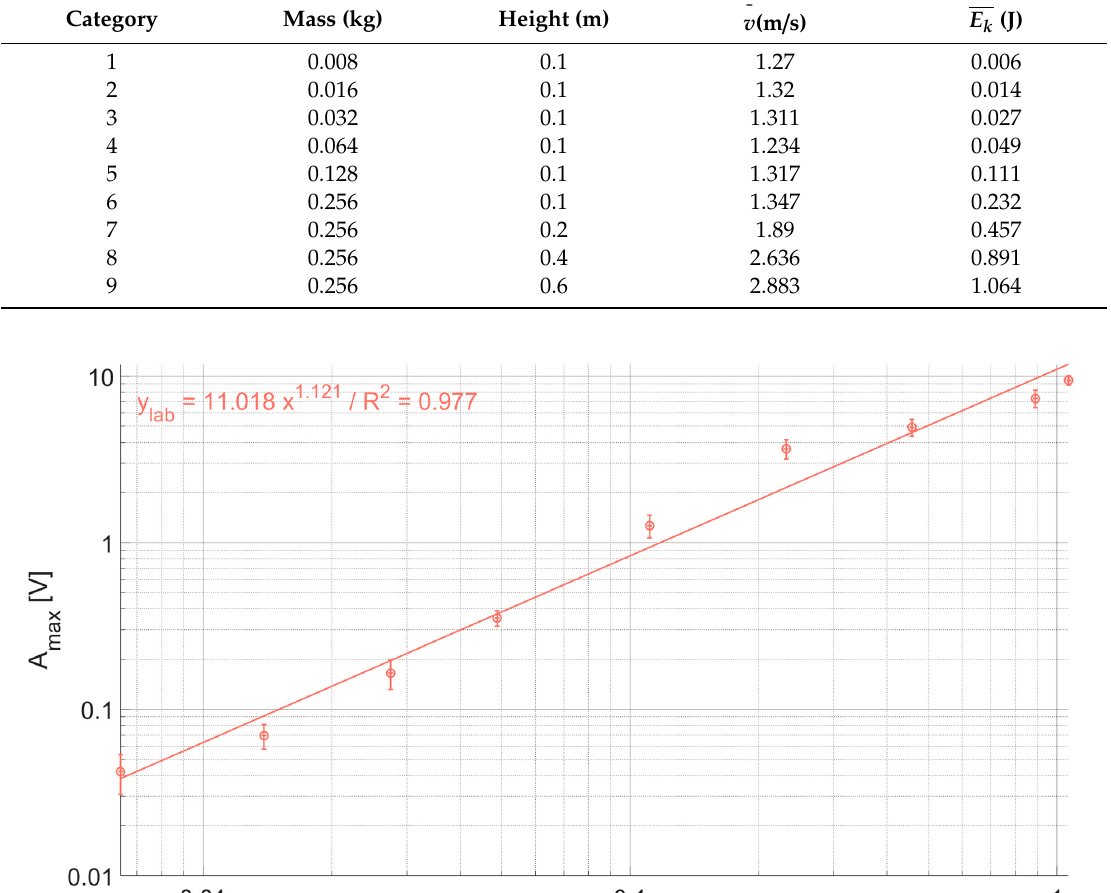
Table 3. Average fall velocity and kinetic energy for each category of weight-height calculated based on high-speed camera video recordings.